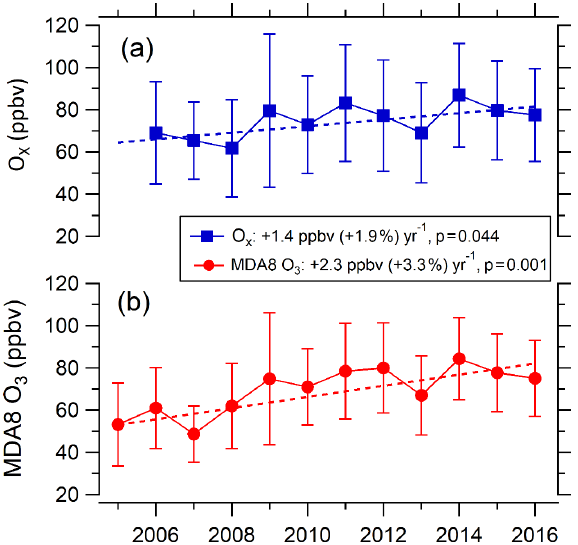
Figure 3. Variations in average MDA8 O 3 and daytime (07:00– 19:00) average O x in Beijing in August between 2005 and 2016.